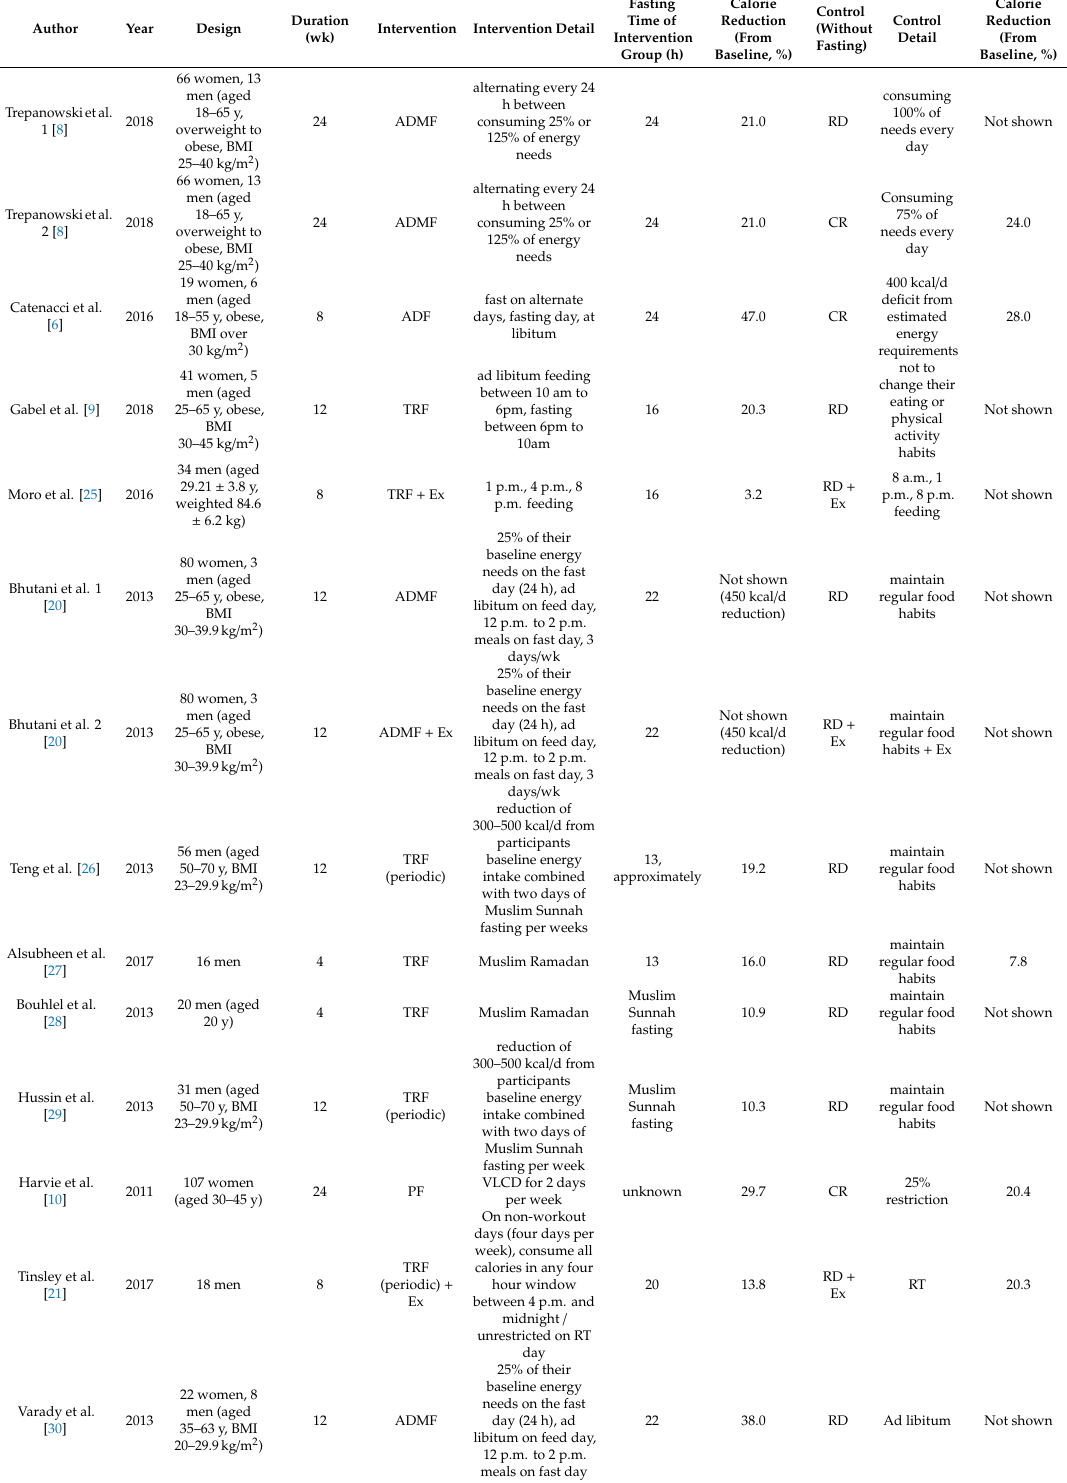
Table 1. Characteristics of the studies included in the